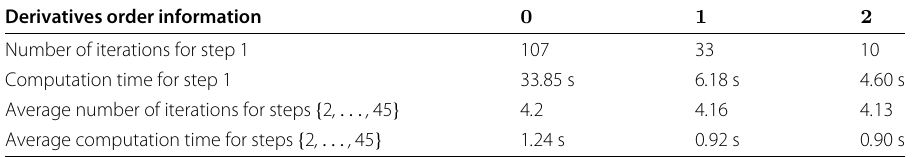
Table 1 Computation costs of the transport maps depending on the derivatives order information given to the minimization algorithm Derivatives order information 0 1 2 Number of iterations for step 1 107 33 10 Computation time for step 1 33 . 85 s 6 . 18 s 4 . 60 s Average number of iterations for steps { 2 , ... , 45 } 4 . 2 4 . 16 4 . 13 1 . 24